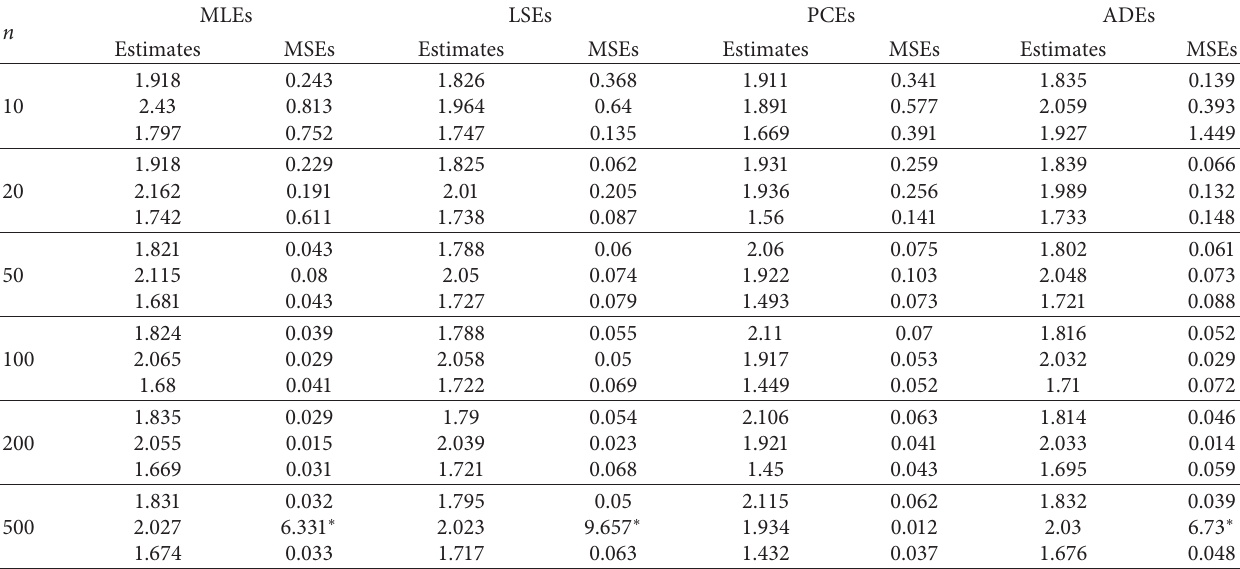
Table 5: Estimates and MSEs of the OFIL distribution for MLEs, LSEs, PCEs, and ADEs for set 4 ( α � 2, θ � 2, and β � 1.5). MLEs n